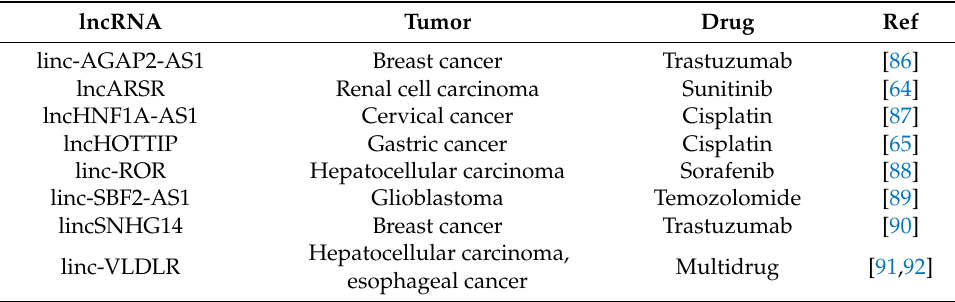
Table 2. Vesicular lncRNAs implicated in cancer drug